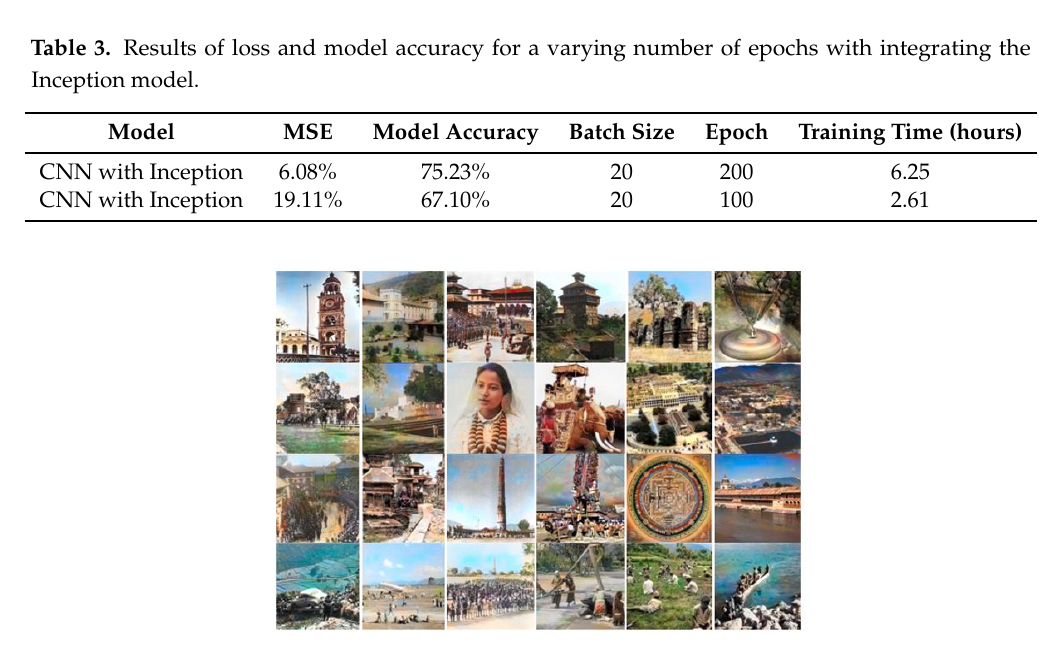
Figure 10. Sample images taken for the MOS-driven user